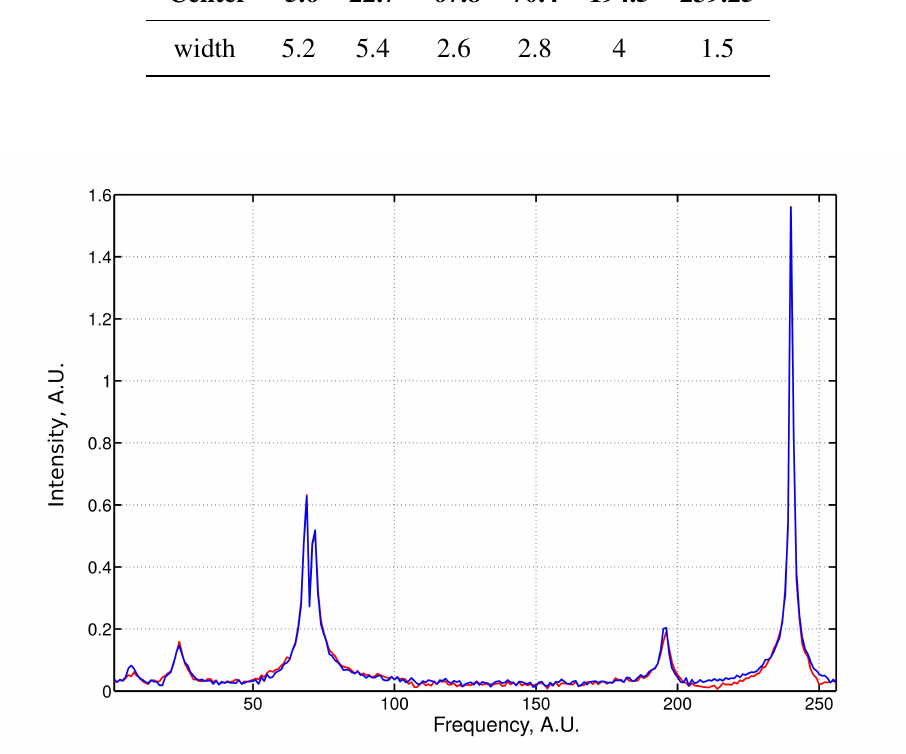
Figure 1. Example of the Lorentzian peak matching pursuit (LPMP) recovery. The size of the spectrum is 256. The number of randomly chosen samples is 120. The result of LPMP recovery (blue line) is compared with the original spectrum (red